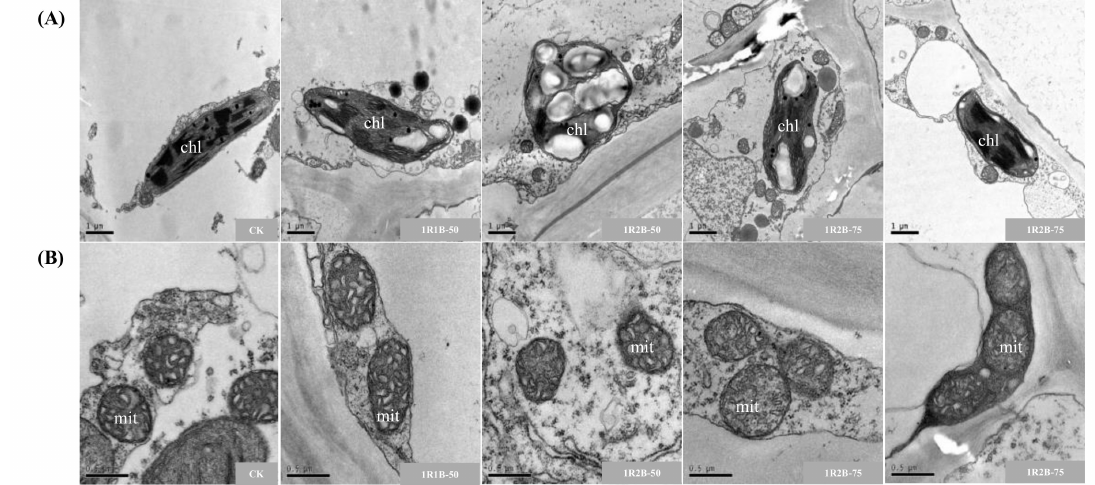
Figure 8. Ultrastructure of chloroplast (chl, A ) and mitochondria (mit, B ) from leaf cells in cucumber seedlings grown under di ff erent light treatments. CK, extremely low irradiance (0–35 µ mol · m − 2 · s − 1